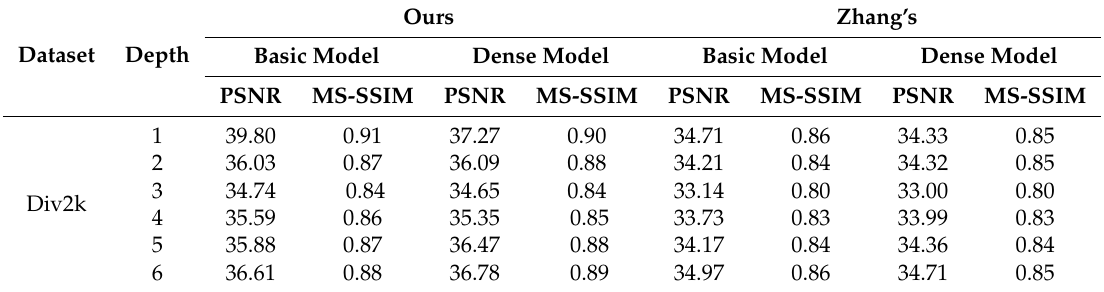
Table 2. The image quality metrics and model variant compared with Zhang’s.